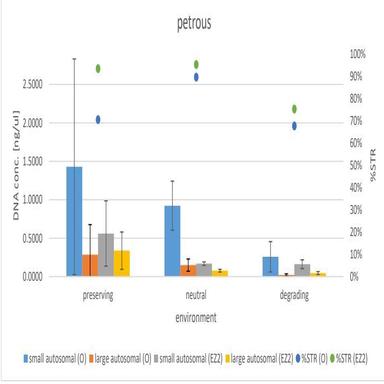
Average DNA concentration result values by the qPCR method for autosomal markers (small and large) and average amplification efficiency (% of STR markers in the profile) depending on soil conditions from which the petrous bone (n=15, 5 per environment) was obtained (O – organic method; EZ2 - EZ2 Connect instrument).